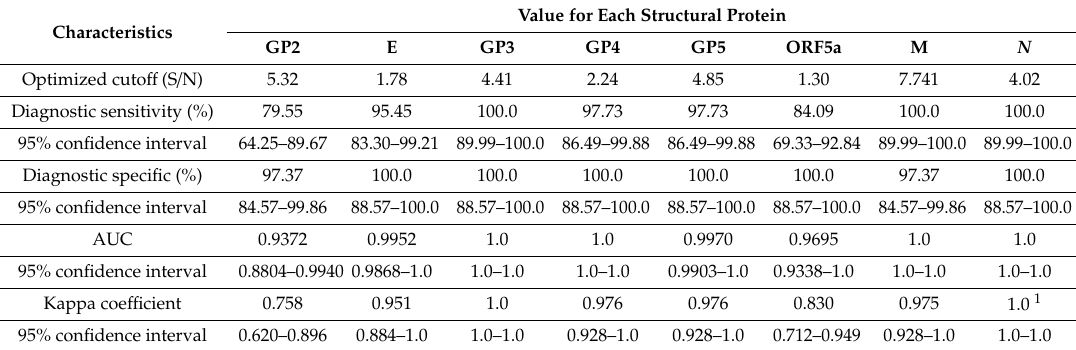
Table 3. ROC and kappa coe ffi cient data for LIPS with eight structural proteins.